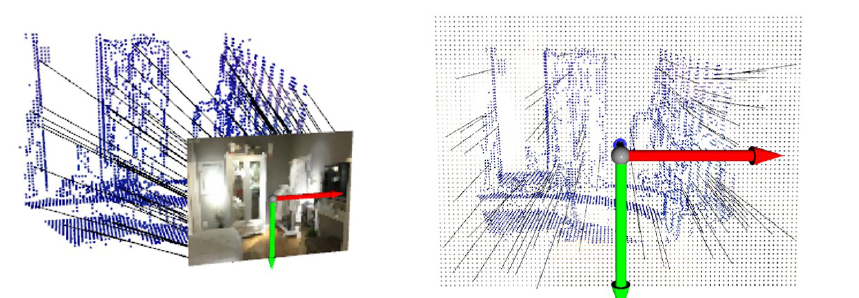
Figure 4. Matching result from SVR-Net(3D).